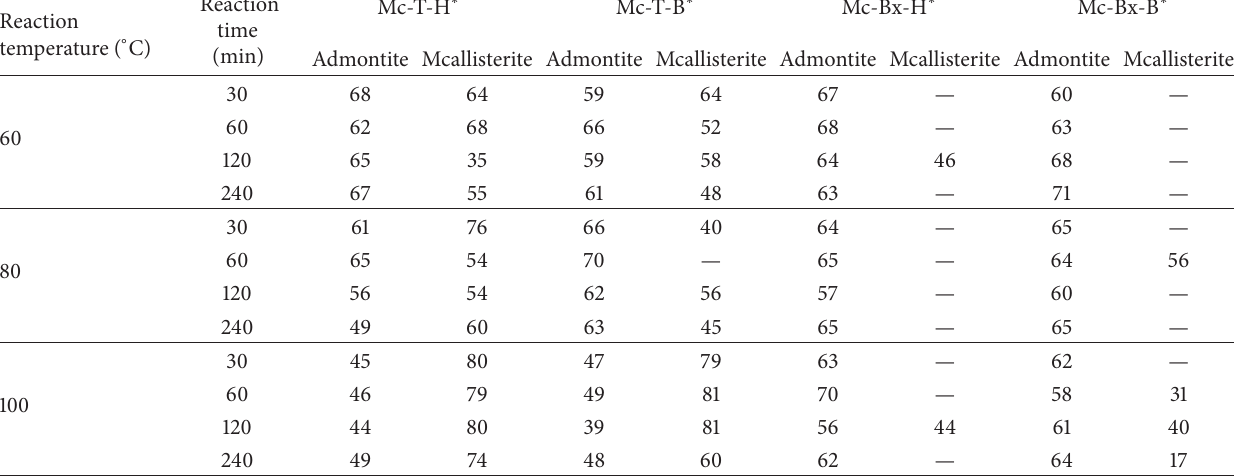
Table 1: XRD scores of the synthesized magnesium borate minerals.